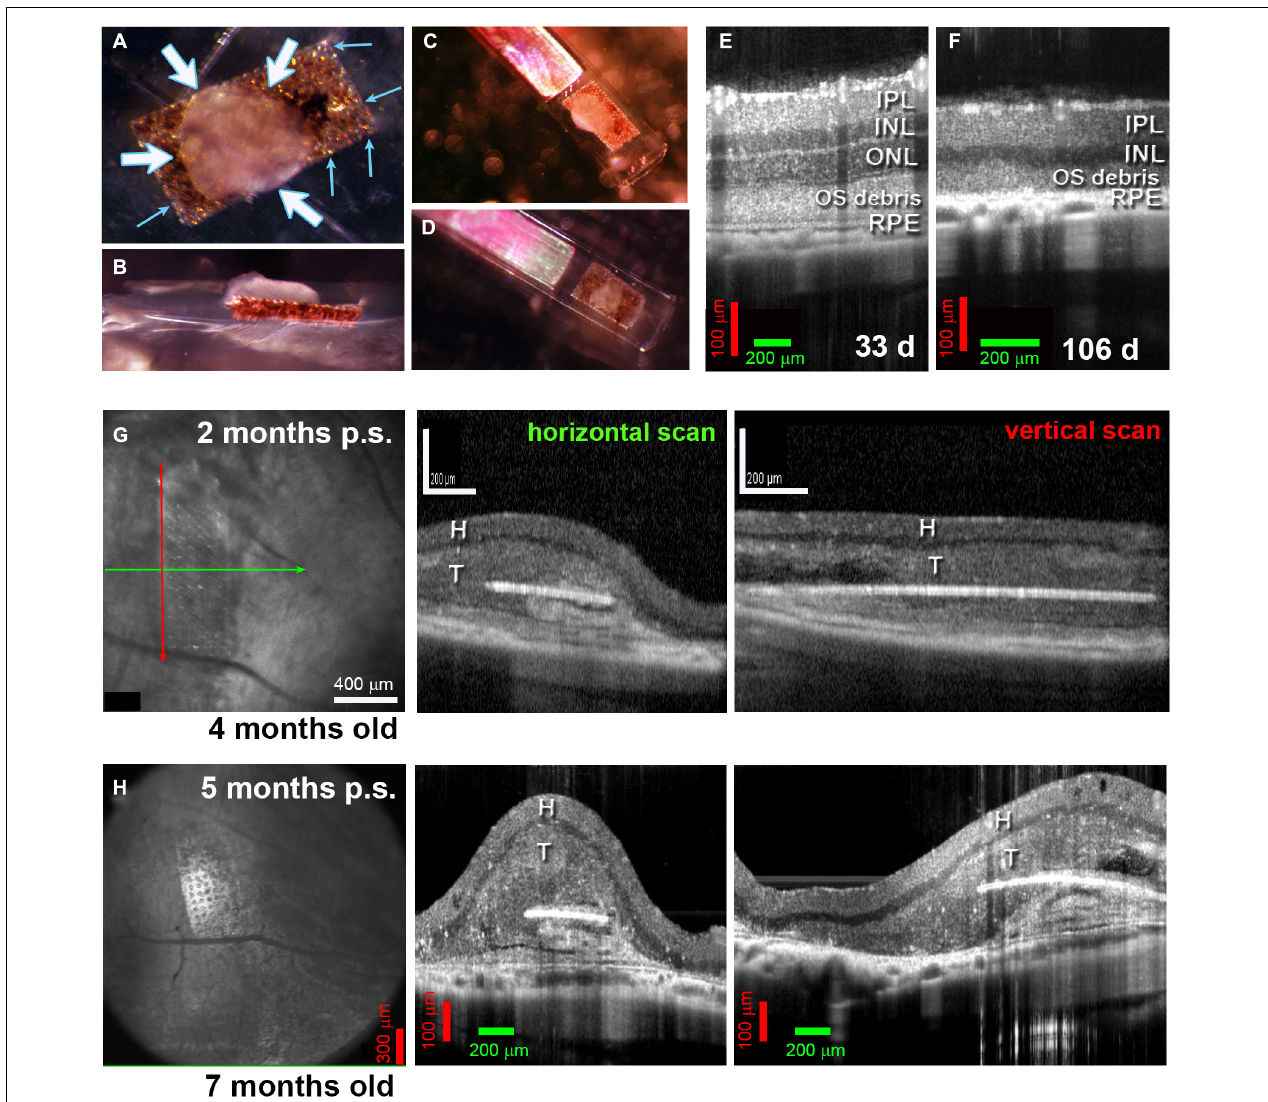
FIGURE 3 | Alginate-embedded co-grafts. (A,B) Preparation of co-graft using MVG alginate. Retina organoid (RO) and RPE were adhered using 1% alginate. (A) View from top. Small blue arrows: RPE layer on the parylene membrane, white arrows: RO sheet adhered to the RPE layer. (B) Side view. (C,D) Examples of co-grafts loaded in nozzle of implantation instrument. (E–H) OCT B-scans. (E) 33-Day-old RCS retina (approximately 3 weeks before transplantation) still contains an outer nuclear layer (ONL). (F) At 106 d of age, the outer nuclear layer has completely disappeared. (G) Scans at 2 months post-surgery of transplant #1 in Figure 5 (Spectralis© Heidelberg Engineering, Inc., USC). Left panel: fundus image (maximum intensity projection). Arrows indicate position of horizontal B-scan (green) and vertical B-scan (red). Horizontal scan (center panel) and vertical scan (right panel) confirm the position of the co-graft in the subretinal space. (H) Corresponding scans of the same transplant at 5 months post-surgery (Bioptigen OCT, UCI). IPL, inner plexiform layer; INL, inner nuclear layer; ONL, outer nuclear layer; OS, outer segments; RPE, retinal pigment epithelium; H, host retina; T,